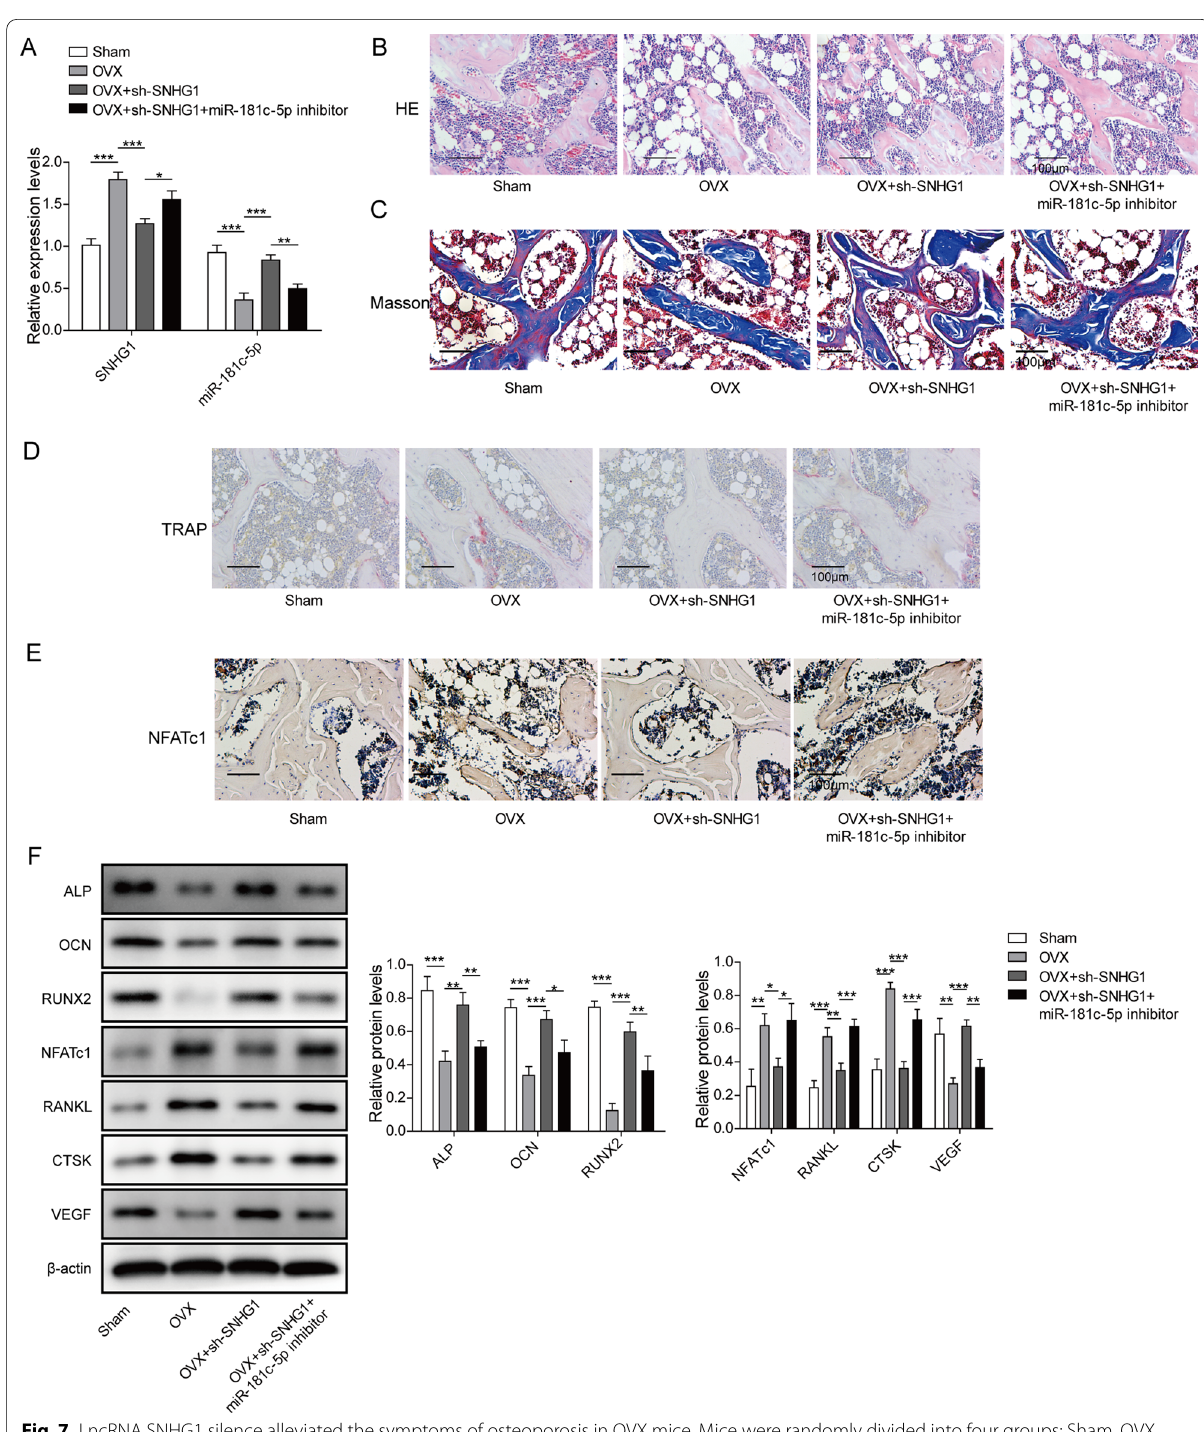
Fig. 7 LncRNA SNHG1 silence alleviated the symptoms of osteoporosis in OVX mice. Mice were randomly divided into four groups: Sham, OVX, OVX sh‑SNHG1 and OVX sh‑SNHG1 miR‑181c‑5p inhibitor groups. Mice were injected the above and femurs were removed after 8 weeks. + + + A The SNHG1 and miR‑181c‑5p expression levels in femoral tissue were detected through qPCR. B Representative HE staining of distal femoral sections showing the bone formation. C Representative images of Masson staining in femurs showing the new bone growth. D Representative photomicrographs of TRAP staining in distal femora showing the bone destruction. E NFATc1 expression was assessed by performing IHC staining. F The protein expression of ALP, OCN, RUNX2, VEGF, NFATc1, RANKL and CTSK were measured using western blot. * P < 0.05, ** P < 0.01, *** P <